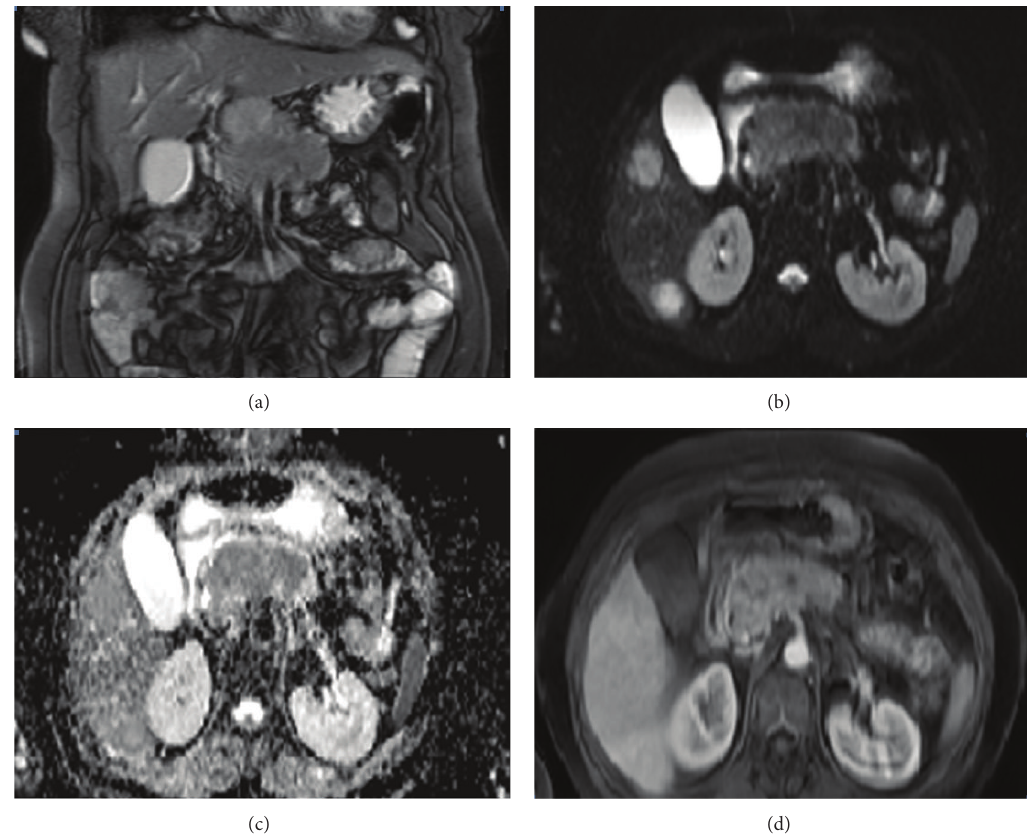
Figure 1: Coronal and axial images from initial abdomen MRI showing the primary tumour found between head and corpus of pancreas and invasion of the adjacent large